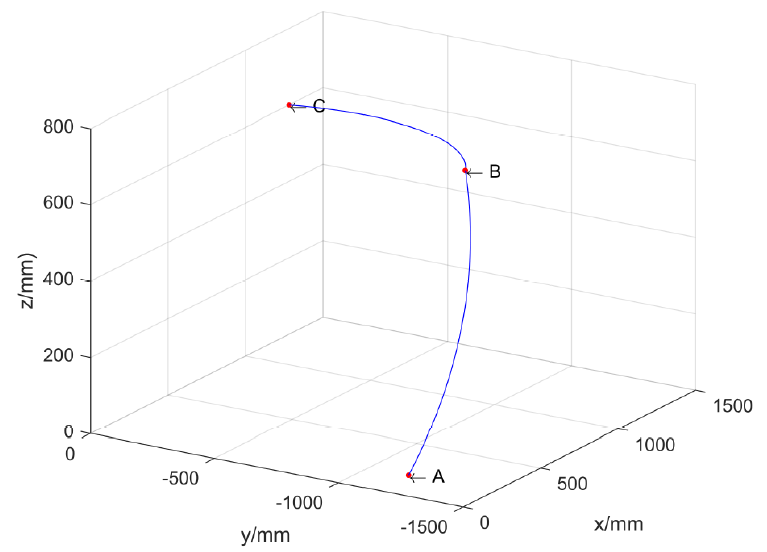
Figure 6. The track curve of loading.